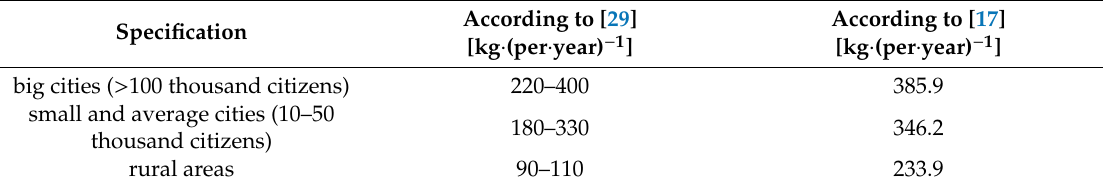
Table 2. Mass waste accumulation indicators in relation to the place of its generation in